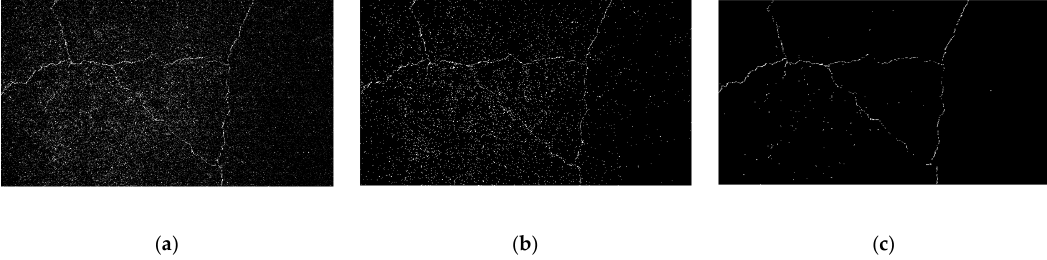
Figure 4. ( a ) Enhanced edge, ( b ) first-level binary, and ( c ) second-level binary images; defected dataset, spatial domain, and Roberts filter.